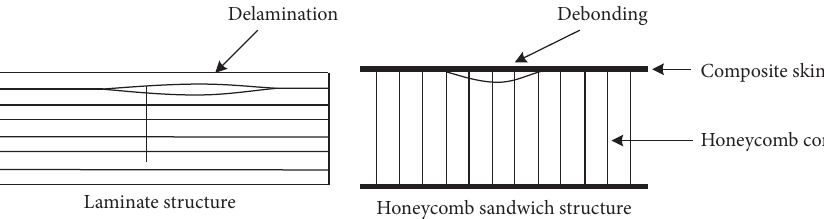
Figure 2: The common defect forms of different composite material